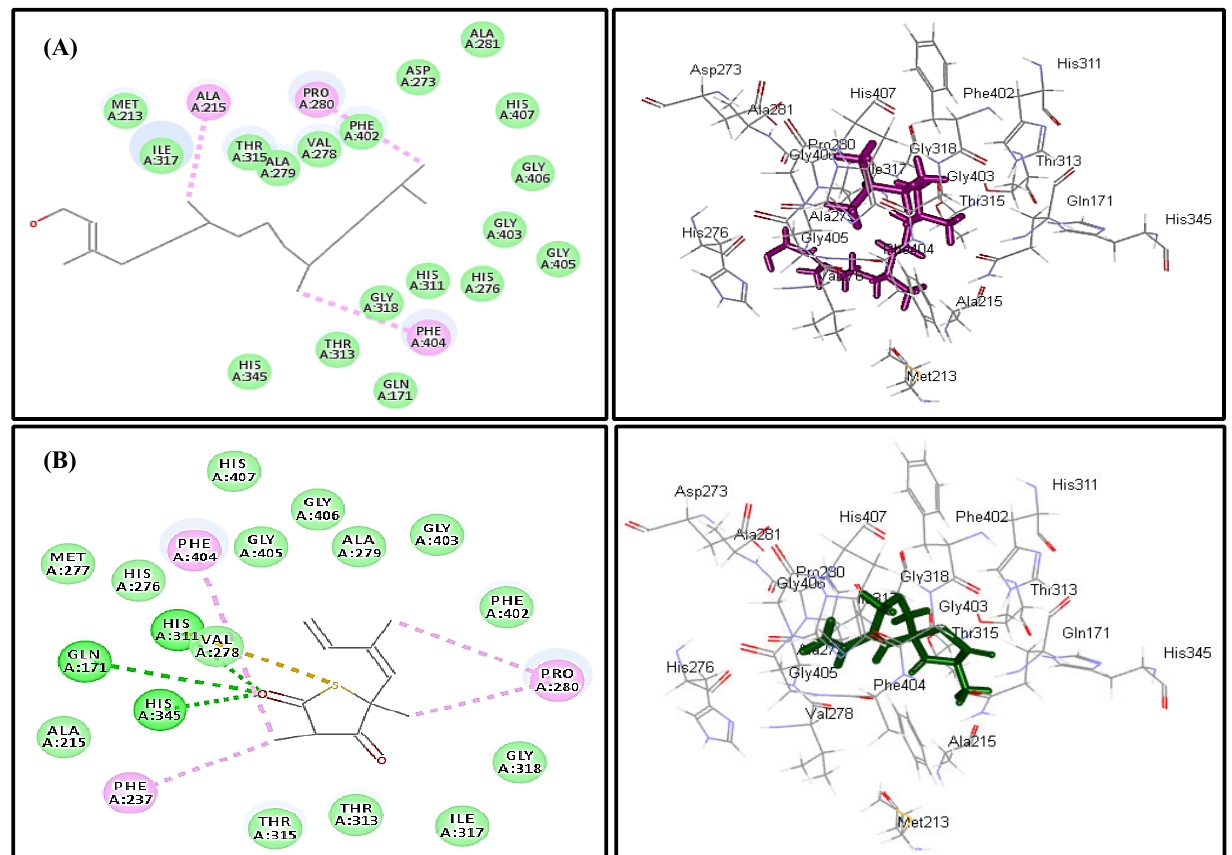
Figure 8. Two ‐ and three ‐ dimensional binding behavior of trans ‐ phytol ( A ) and thiolactomycin; the co ‐ crystalized ligand Figure 8. Two- and three-dimensional binding behavior of trans -phytol ( A ) and thiolactomycin; the co-crystalized ligand ( B ) ( B ) within MTB C171Q receptor KasA inhibitor (4C6X) active site using C ‐ docker protocol. within MTB C171Q receptor KasA inhibitor (4C6X) active site using C-docker